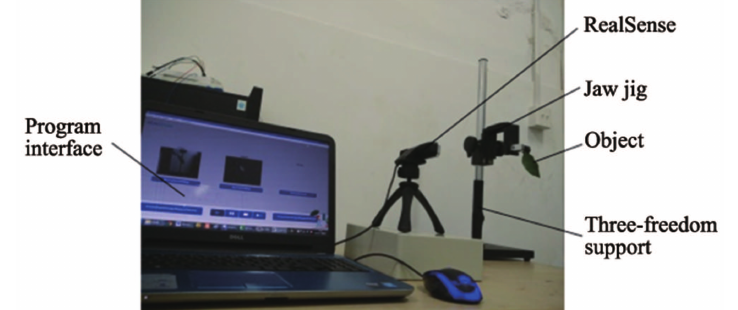
Figure 10. Experiment device and scene.